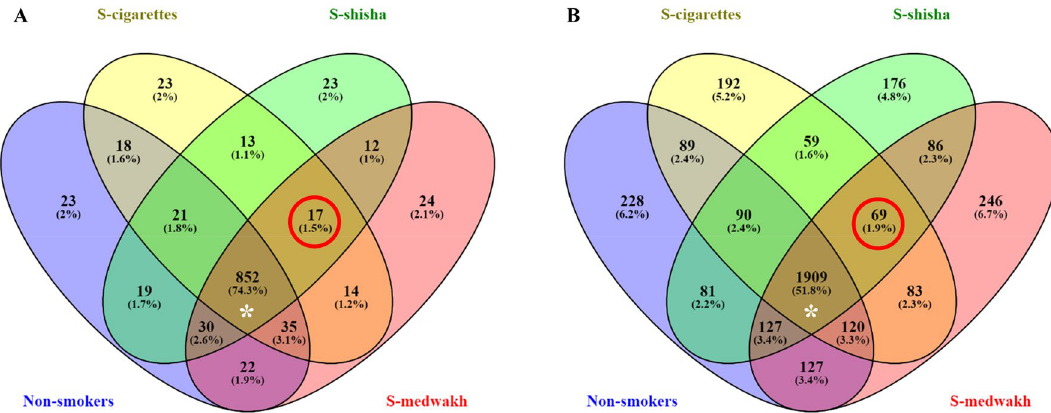
Figure 1. Venn diagram of exclusive and shared taxonomically unique microbiota (( A ) genus, and ( B ) species) detected in subgingival plaque samples from non-smokers and smokers of cigarettes, medwakh, or shisha. Red circles indicate genera or species exclusively found in smoking groups (but not in non-smokers). Asterisk (*) represents the genera and species shared among all four